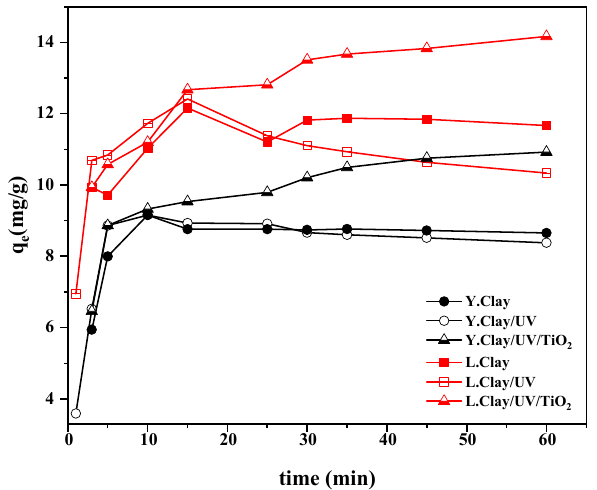
Figure 13. Photocatalytic degradation efficiency of crystal violet under clays, under clays and TiO 2 + Clays + UV. Conditions: Clay ( m = 0.1 g), TiO 2 ( m = 0.1 g), V = 200 mL, C = 12 mg/L, Ph = 2, T = 30 °C.